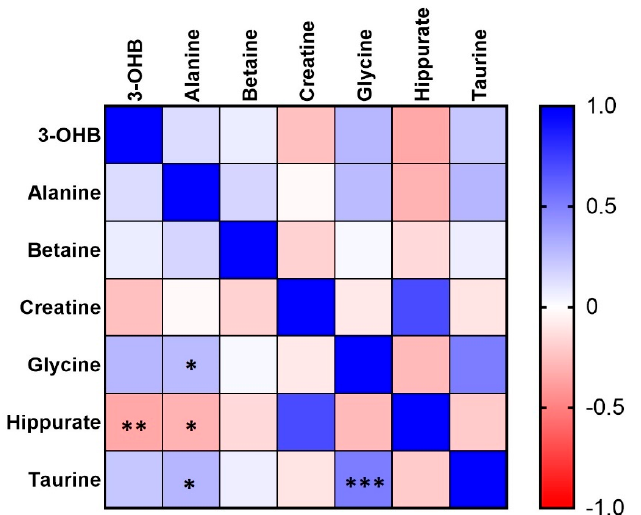
Figure 3. Heatmap representing the correlation coefficient matrix (reflecting Pearson’s correlation coefficients) between urine metabolites identified as potential biomarkers differentiating BAV from controls. * p < 0.05; ** p < 0.01; *** p < 0.001.